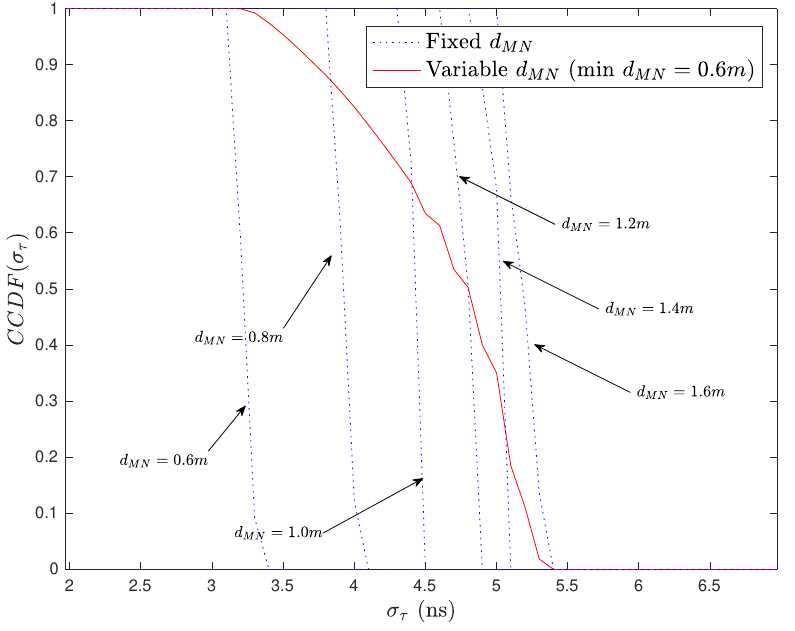
Figure 8. CCDF of the RMS delay spread considering different distances between the transmitter and